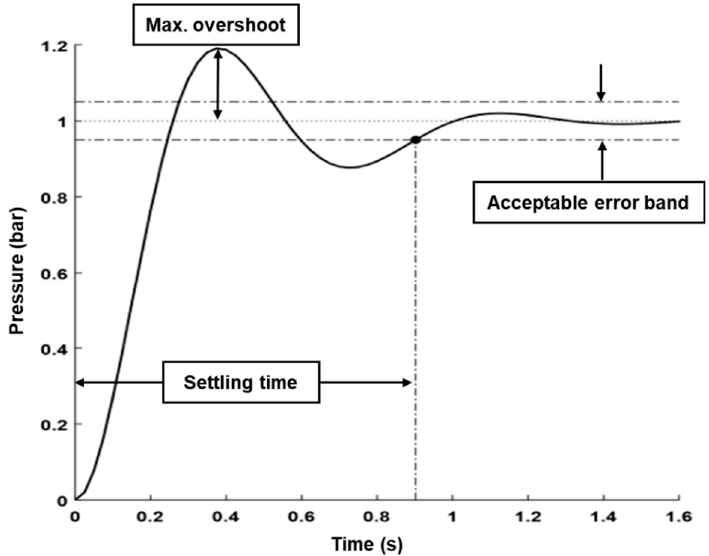
Figure 8. The responses of the PID control algorithm.